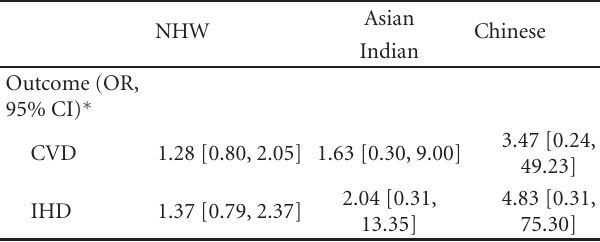
Table 3: Multivariate adjusted odds ratio for association between Lp(a) (top quintile versus bottom 4 quintiles) and CVD